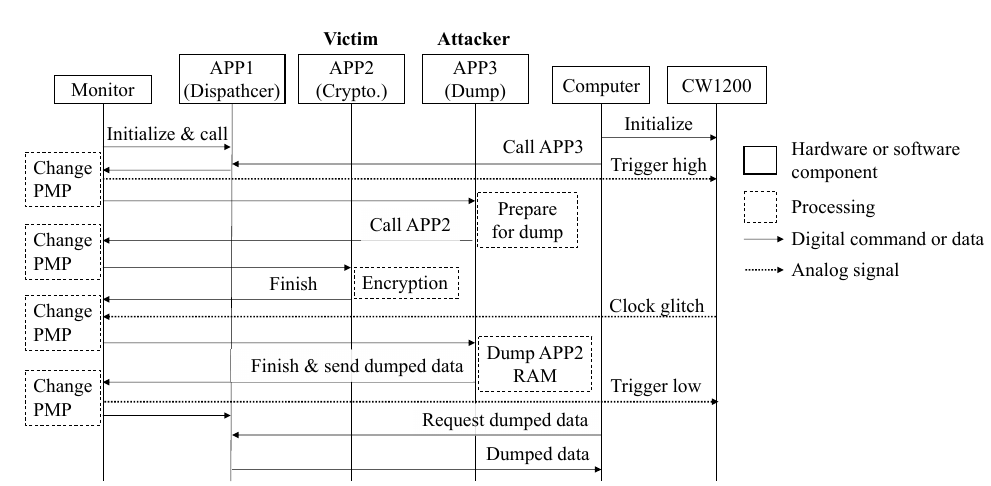
Figure 10: Sequence diagram for